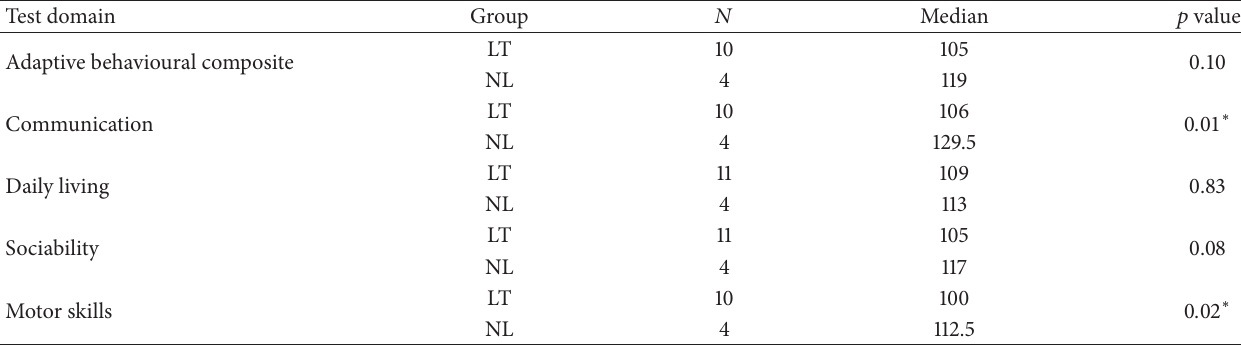
Table 3: Vineland scores for LT and NL